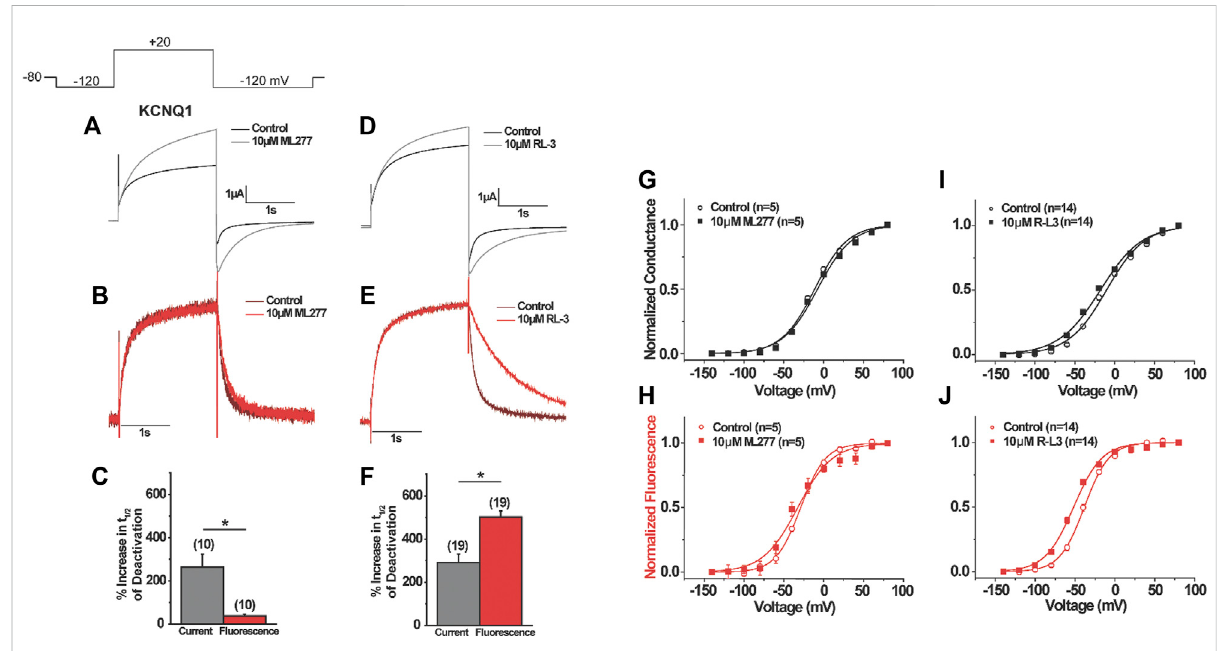
FIGURE 5 Voltage clamp fl uorometry of the effects of ML277 and RL-3 on KCNQ1. (A – F) Representative current (top) and fl uorescence (middle) recordings of KCNQ1 before and after (A,B) ML277 application or (D – E) R-L3 application. Voltage protocol shown in inset. (C,F) Summary of (C) ML277 and (F) R-L3 effects on the deactivation of the current (gray) and fl uorescence (red). (G – J) G(V) (top) and F(V) (bottom) for KCNQ1 before (open symbols) and after (closed symbols) application of ML277 (G – H) or R-L3 (I – J)